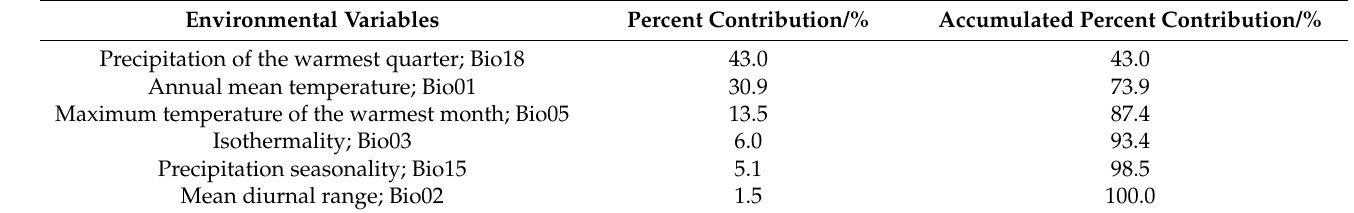
Table 2. The accumulated contribution of selected environmental variables to the potential distribu- tion of the susceptible hosts Q. mongolica and Q. liaotungensis of M. raddei defined by MaxEnt.